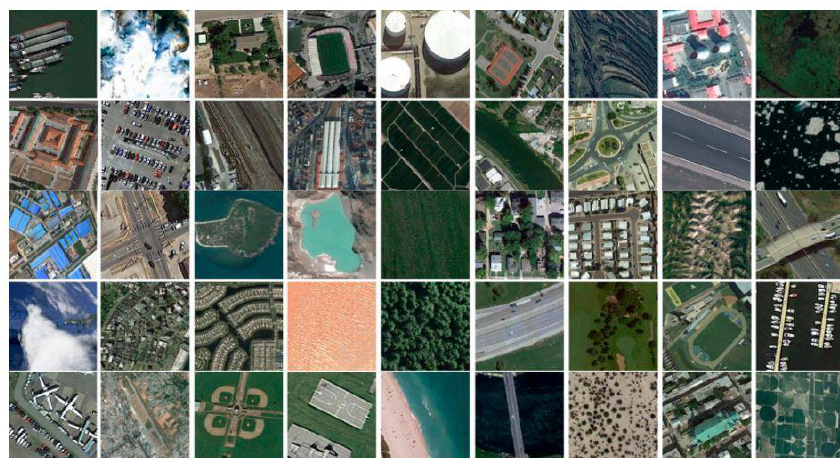
Figure 4. Sample images of NWPU45 dataset.